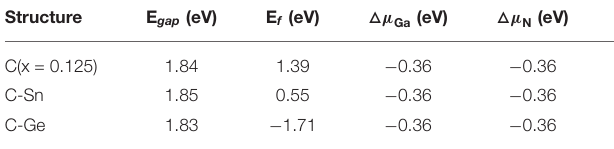
TABLE 2 | The calculated band gaps (E gap ), minimum defect formation energies (E f ), and chemical potentials of N and Ga.